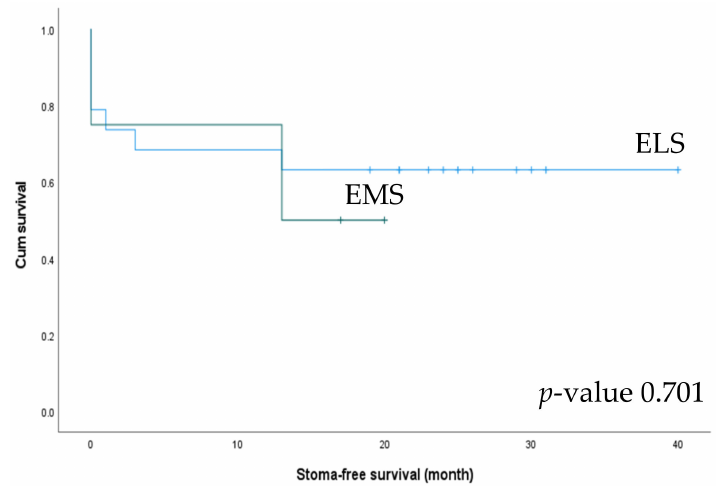
Figure 6. Stoma-free survival of patients undergoing left-side colectomy in the elective surgery (ELS) and emergency surgery (EMS) groups. Table 5. Stoma creation in patients with left-sided